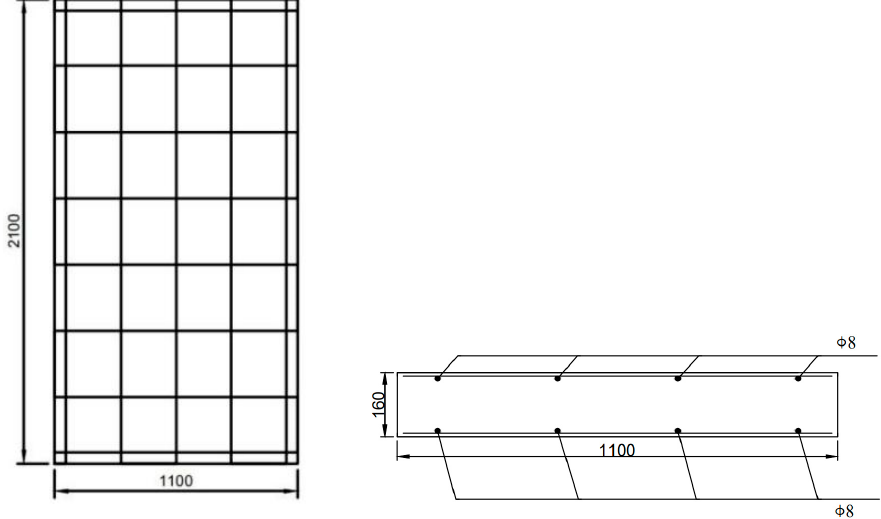
Figure 9. RC shear walls dimensions and reinforcement distribution.